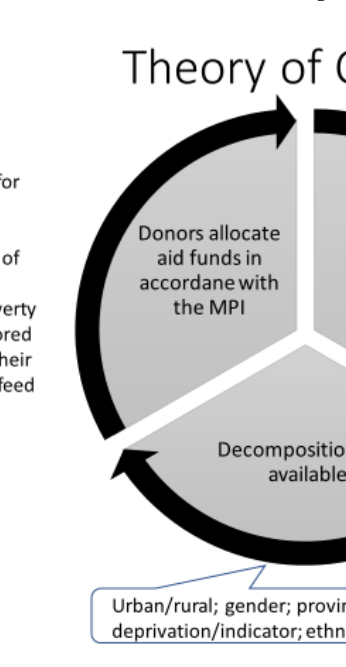
Figure 12. Theory of the change that underlies the relationship between ODA and MPI. Source: Author’s elaboration.